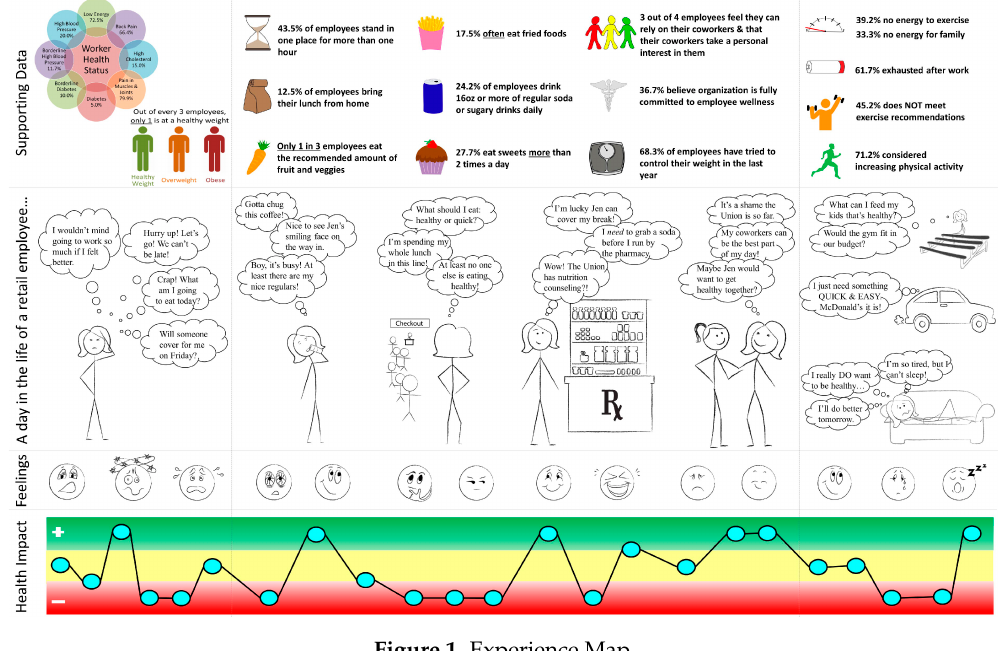
Figure 1. Experience Map.